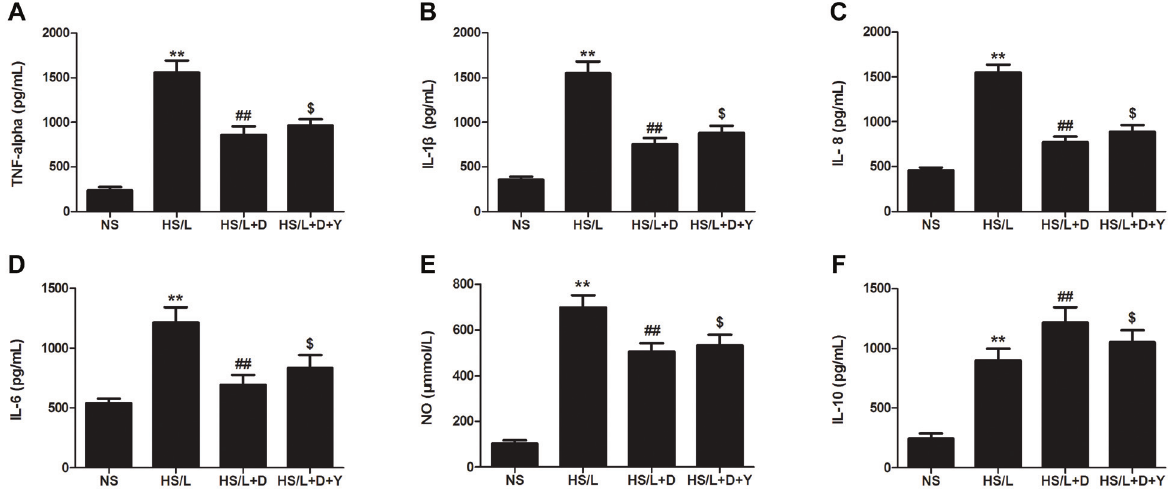
Figure 4. Plasma levels of TNF- a ( A ), IL-1 b ( B ), IL-8 ( C ), IL-6 ( D ), NO ( E ) and IL-10 ( F ) of the NS control (normal saline), hemorrhage/ resuscitation plus lipopolysaccharide (HS/L), HS/L plus dexmedetomidine (HS/L + D), and HS/L + D plus yohimbine (HS/L + D + Y) groups. Data are reported as means ± SD. **P o 0.01 vs the NS group; ## P o 0.01 vs the HS/L group; $ P o 0.05 vs the HS/L + D group (ANOVA).